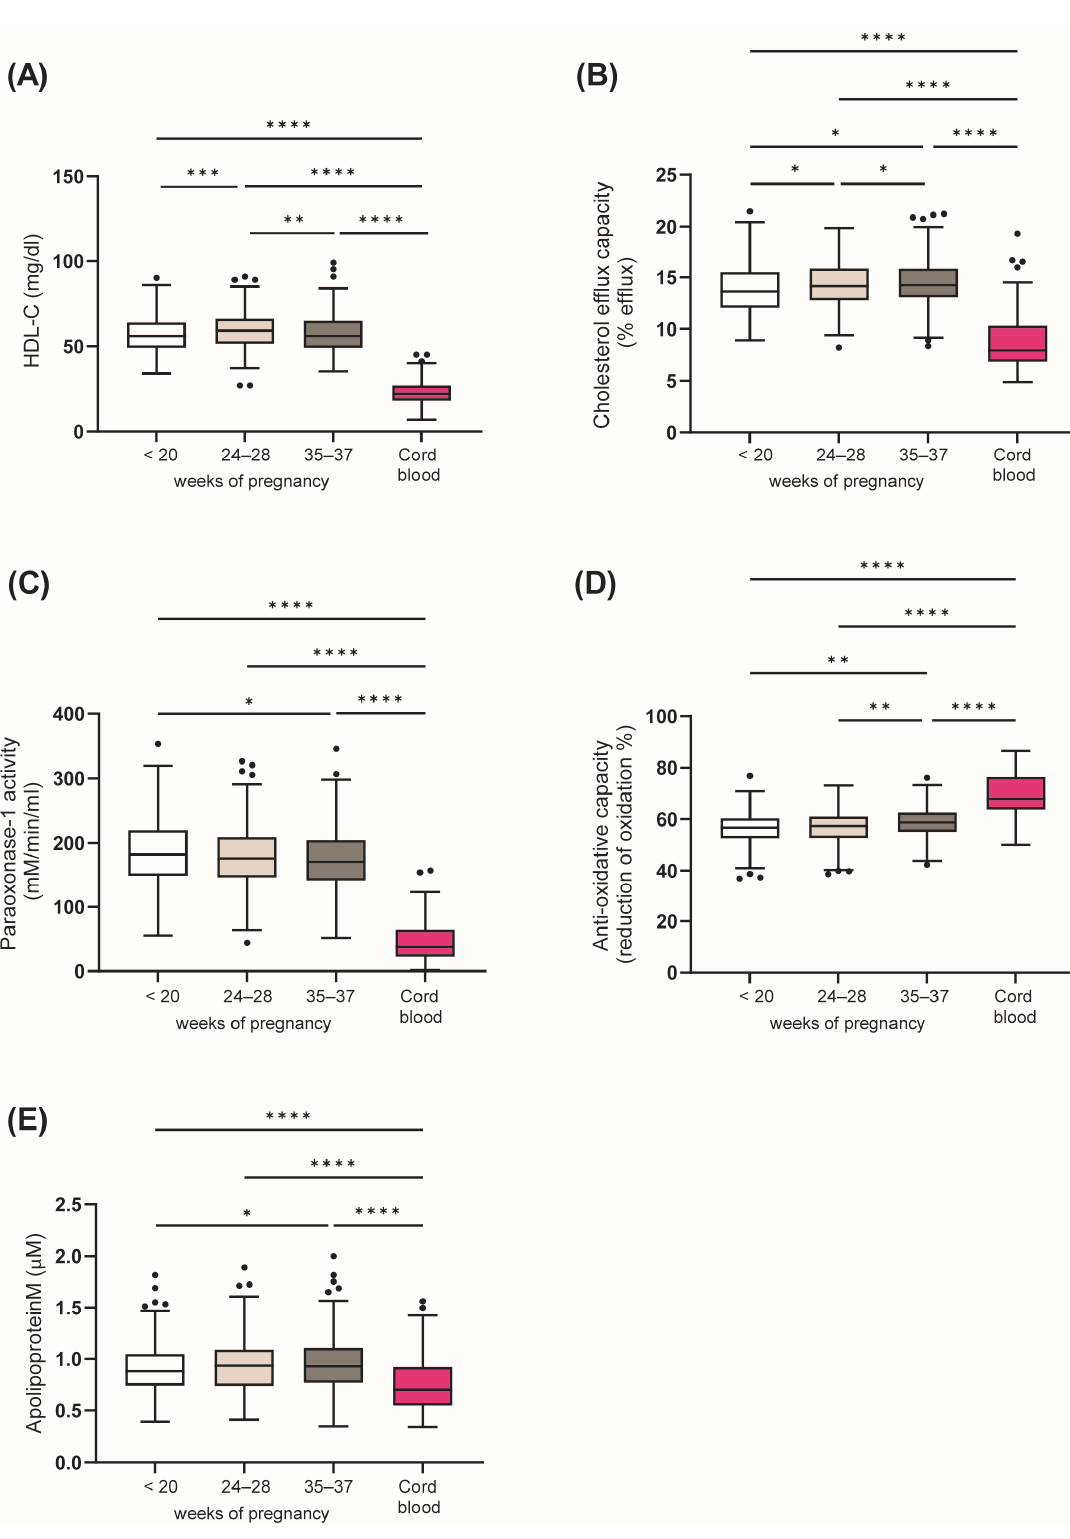
Figure 1. Changes in HDL-related parameters during pregnancy and comparisons with cord blood. HDL-C ( A ), the ability to promote cholesterol efflux ( B ) and activity of HDL-associated PON1 ( C ) were assessed. ( D ) Serum anti-oxidative capacity and ( E ) apolipoprotein M levels. Data are presented as Tukey-Boxplots, showing the median and interquartile ranges, as well as minimum, maximum values and outliers. * p < 0.05, ** p < 0.01, *** p < 0.001 , **** p < 0.0001 based on paired t -test.